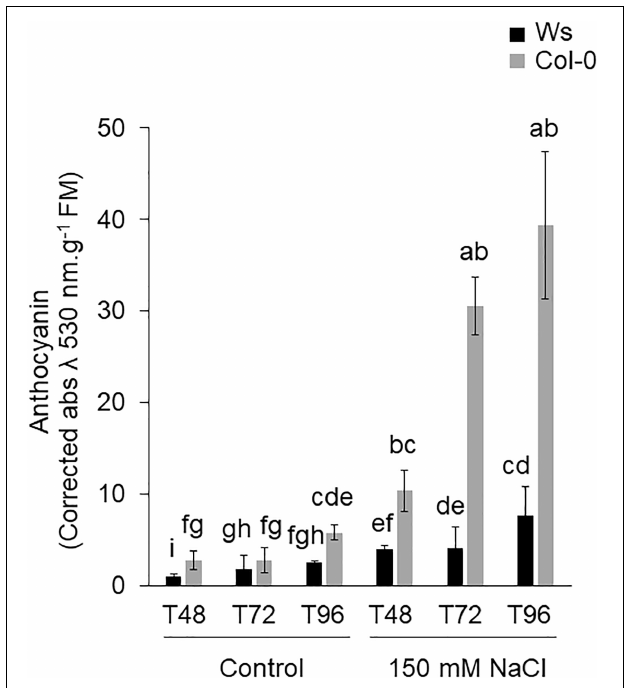
FIGURE 2 | Shoot anthocyanin content of Ws and Col-0 at T48, T72, and T96 under control and 150 mM NaCl conditions. Data are means ± standard deviation of three biological replicates. Means followed by the same letter are not significantly different according to Dunn test.